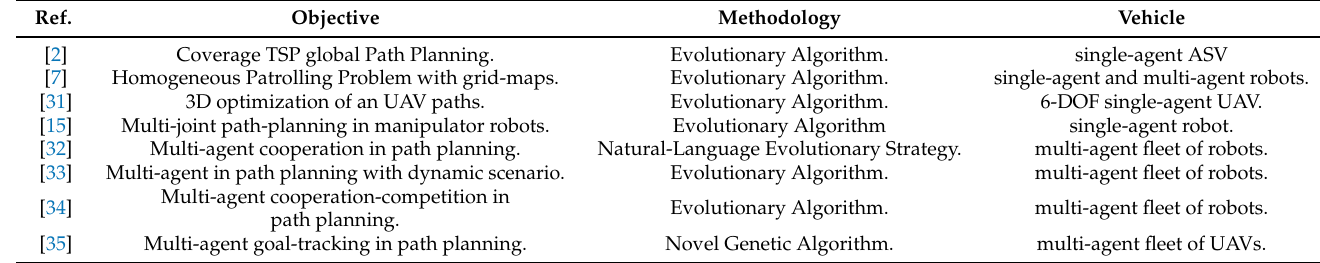
Table 2. Brief summary of path planning using